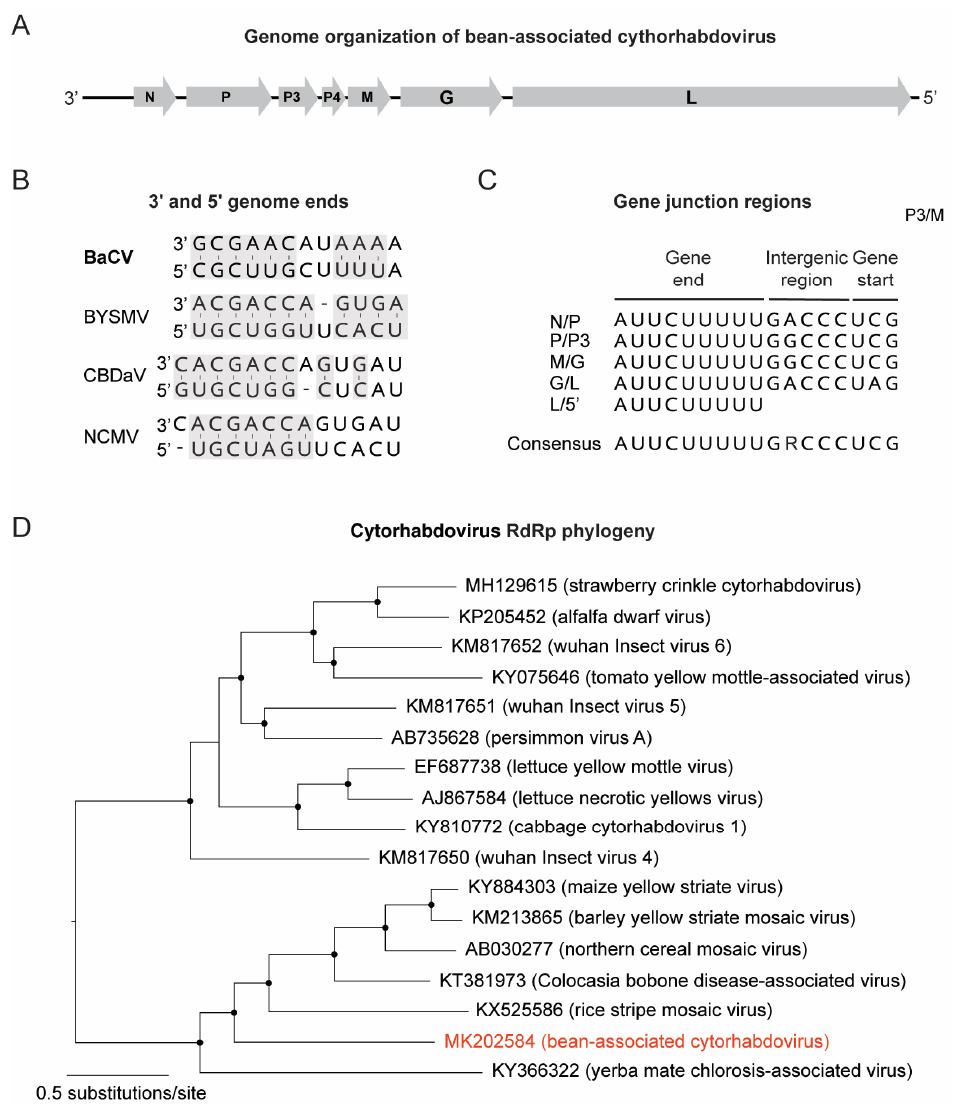
Figure 4. Genome organization and phylogeny of bean-associated cytorhabdovirus (BaCV). ( A ) BaCV genome structure showing the six open reading frames (ORFs) (N, P, P3, M, G, and L). ( B ) Complementary structure of the 5′ and 3′ ends in the BaCV, barley yellow striate mosaic virus (BYSMV), colocasia bobone disease-associated virus (CBDaV), and northern cereal mosaic virus (NCMC) genomes. ( C ) Conserved motif sequences in the intergenic regions. ( D ) Maximum likelihood tree inferred using an alignment of RdRp (L protein) from 17 available genomes of members in the genus Cytorhabdovirus . The tree was midpoint rooted for purposes of clarity, and the nodes indicate by a black dot have Shimodaira–Hasegawa-like branch test ≥0.9. BaCV is highlighted in red. The viral genome presented all five ORFs found in most rhabdoviruses: nucleoprotein (N) (ORF1) (451 aa), phosphoprotein (P) (ORF2) (445 aa), matrix (M) (ORF5) (287 aa), glycoprotein (G) (ORF6) (520 aa), and an RNA-dependent RNA polymerase (L) (ORF7) (2114 aa), as well as a putative movement protein (P3) (ORF3) (189 aa) and a hypothetical protein P4 (ORF4, 78 aa) (Table 3), which is also present in the genome of other members of the genus Cytorhabdovirus [30]. The predicted ORFs 3 and 4 are not separated by the conserved gene junction described above. A putative homolog of this small protein (P4) was recently described in the genome of yerba mate chlorosis-associated virus (YmCaV) (P4 protein, ARA91089), which also does not have any conserved gene junction between